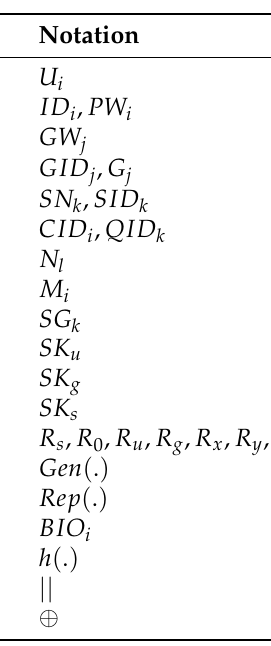
Table 1. Notations and definitions of Chen et al.’s